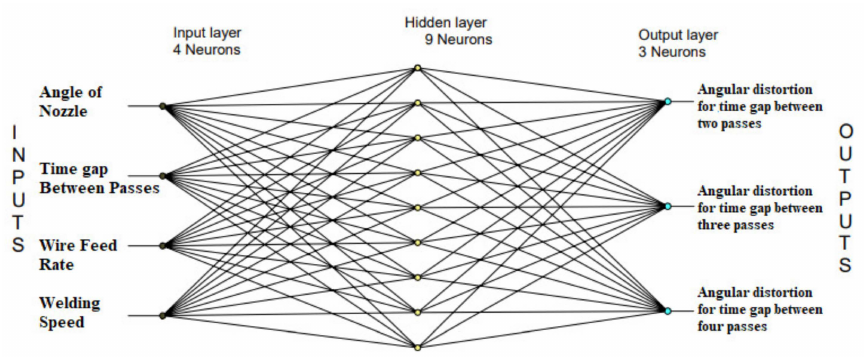
Figure 6. Network 4-9-3 with nine